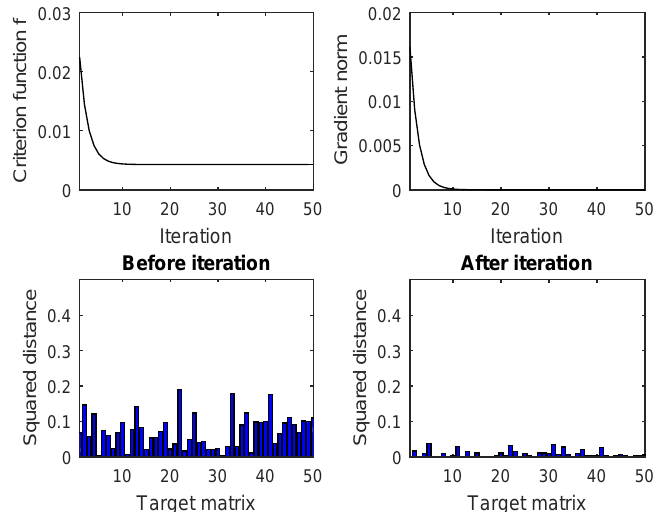
Figure 9. Mean-matrix computation over over the pseudo-orthogonal group O ( 1,1 ) : Values of the criterion function in Equation (38) during iteration, of the pseudo-norm of its pseudo-Riemannian gradient, of the distances D g ( X , X k ) before iteration ( X = X ( 0 ) ) and after iteration ( X = µ )